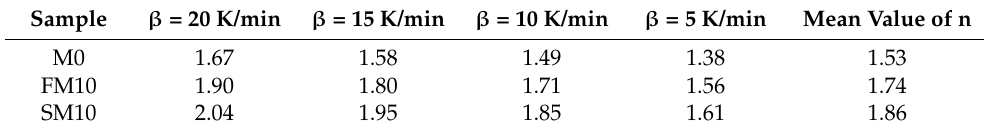
Table 5. The crystallization exponents of the different ceramic cores.